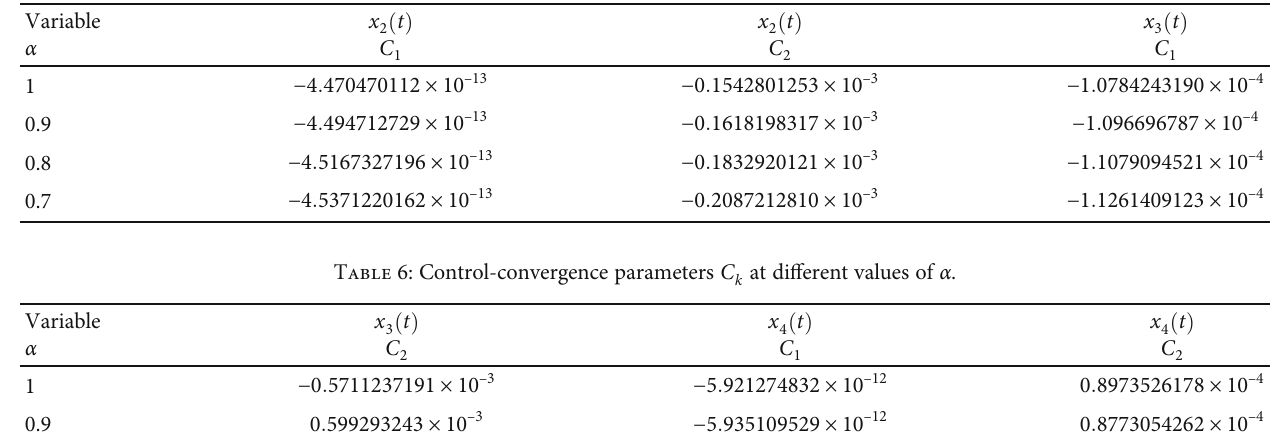
at di ff erent values of α . k